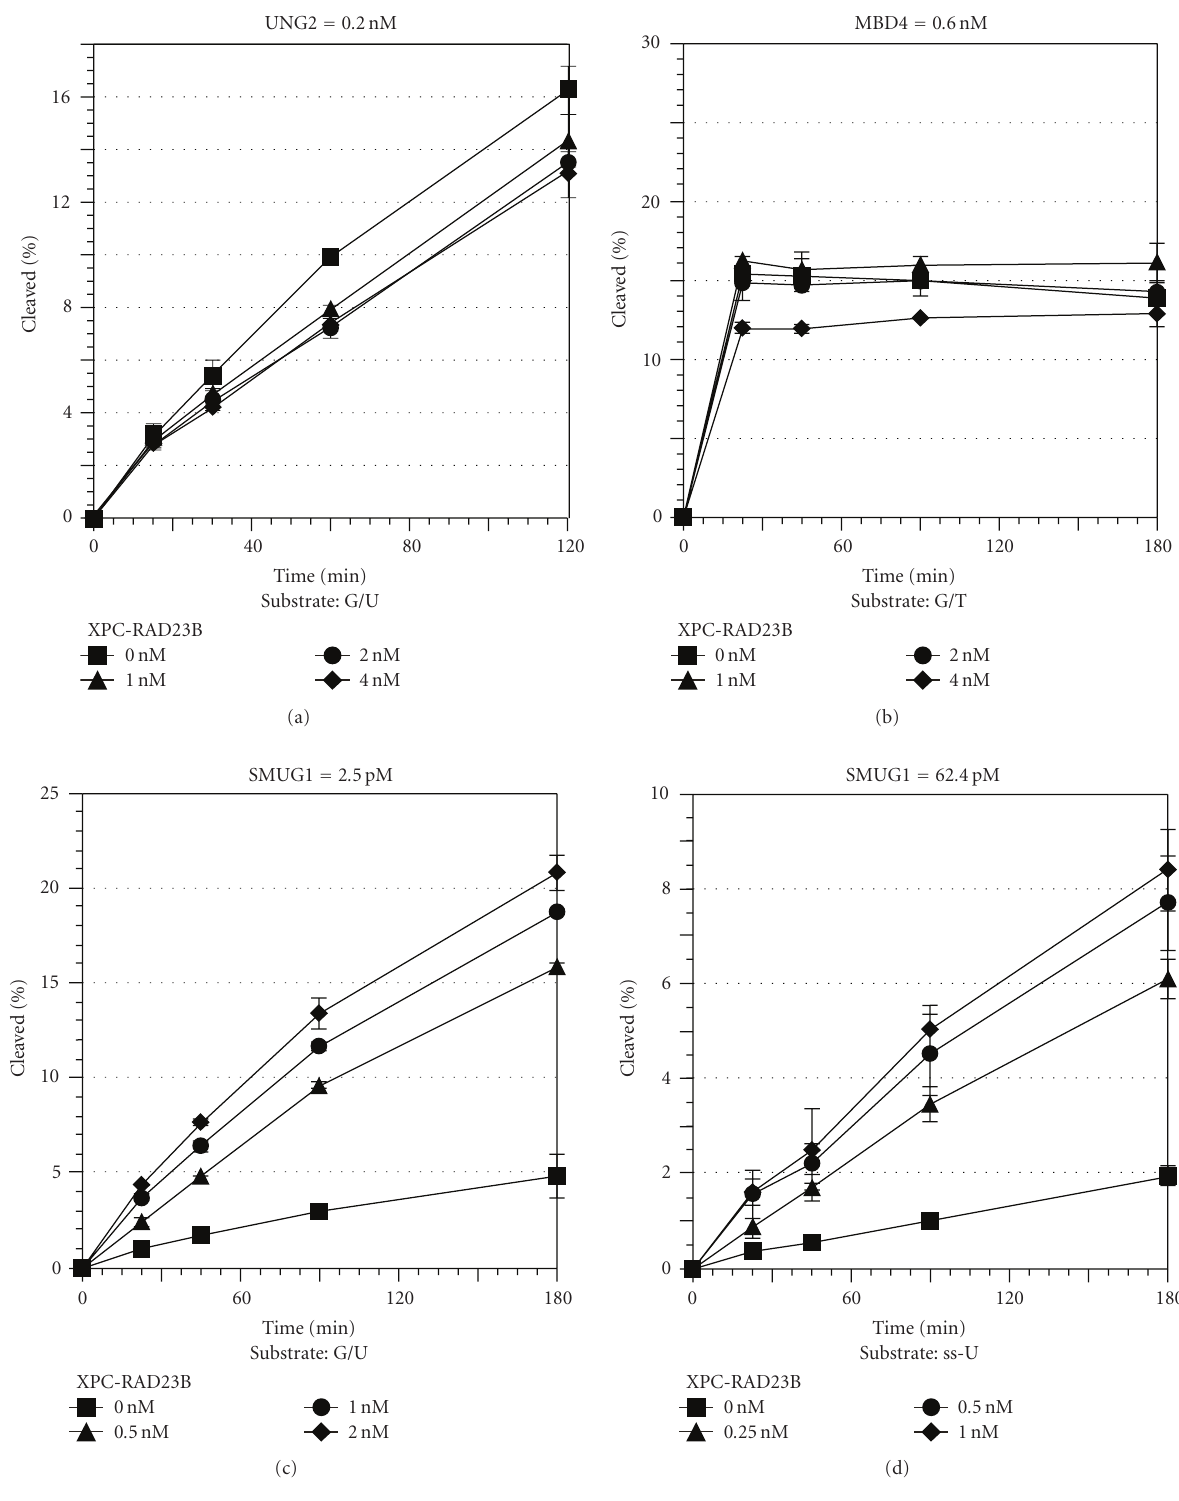
Figure 6: The e ff ect of XPC on the activity of other DNA glycosylases involved in G/T and/or G/U mismatch repair. The activity of UNG2 (a), MBD4 (b), or SMUG1 ((c) and (d)) was measured in the presence of various amounts of XPC-RAD23B. In each reaction, 1.6 nM of 60-bp DNA containing a single G/U mismatch ((a) and (c)), G/T mismatch (b), or single stranded 30-mer oligonucleotide containing a single uracil residue (d) was used as the substrate. The reaction was done at 30 ◦ C for the time indicated with specified concentration of purified recombinant proteins as shown. The DNA samples were then purified and subjected to alkali-treatment to cleave the resulting AP sites and separated with denaturing PAGE. The ratio of the cleaved product was calculated and plotted as a graph. The mean values and standard errors were calculated from at least two independent